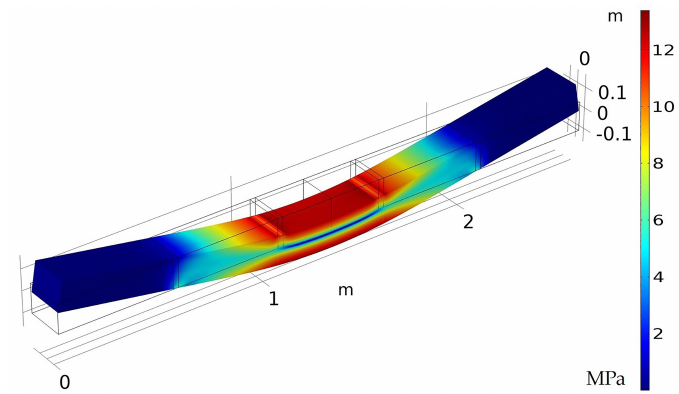
Figure 9. FEA results for core stress under deformation for sample 3.